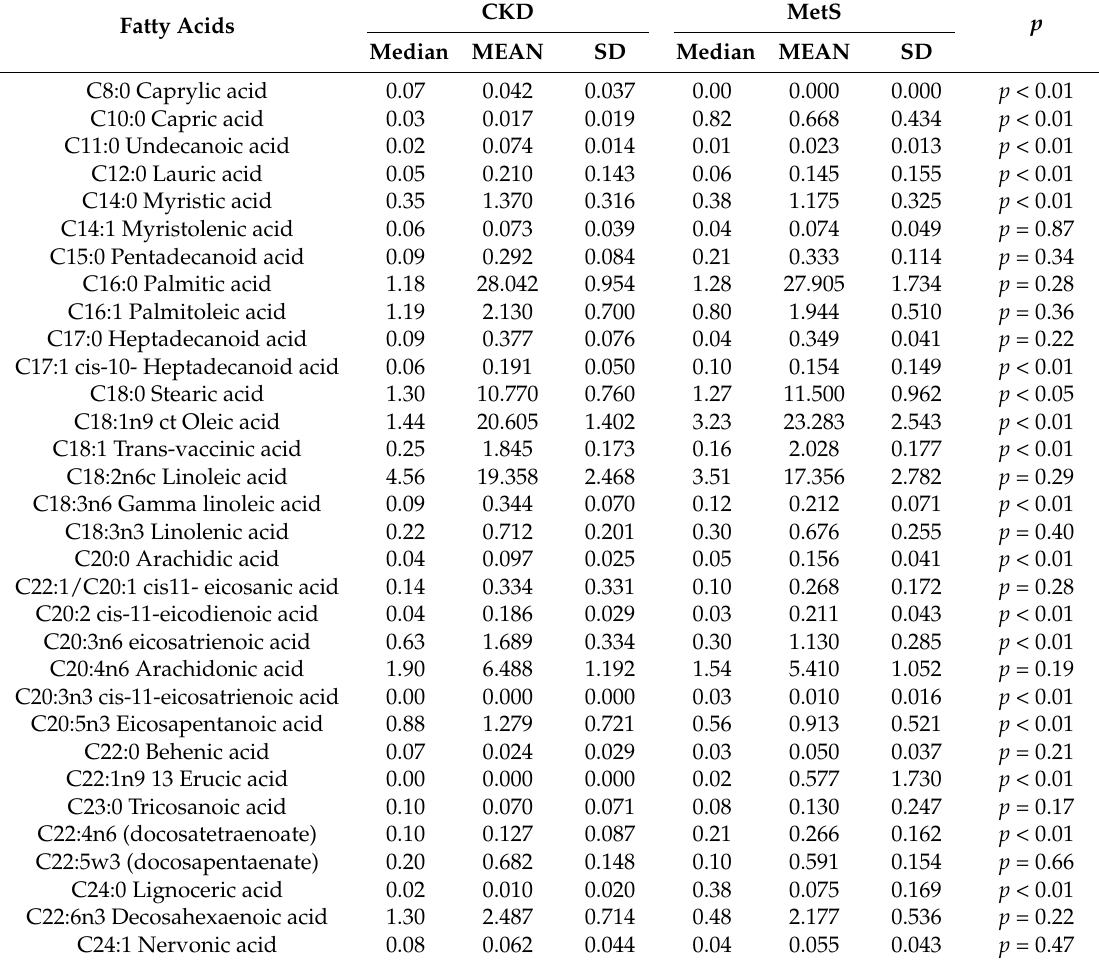
Table 3. Comparison of the amount of FA in CKD vs MetS [%].